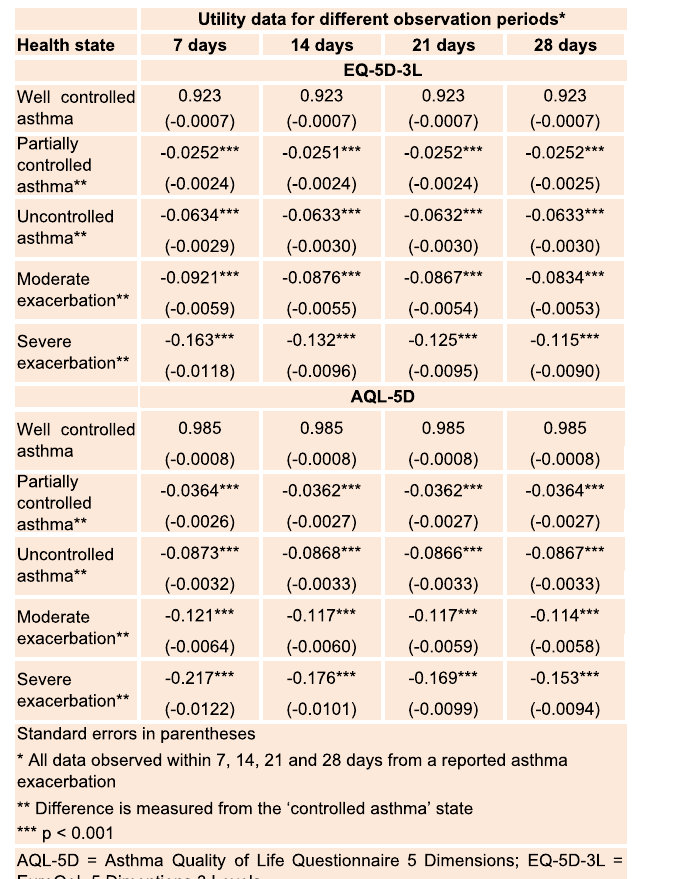
Table 2 Utilities by asthma health